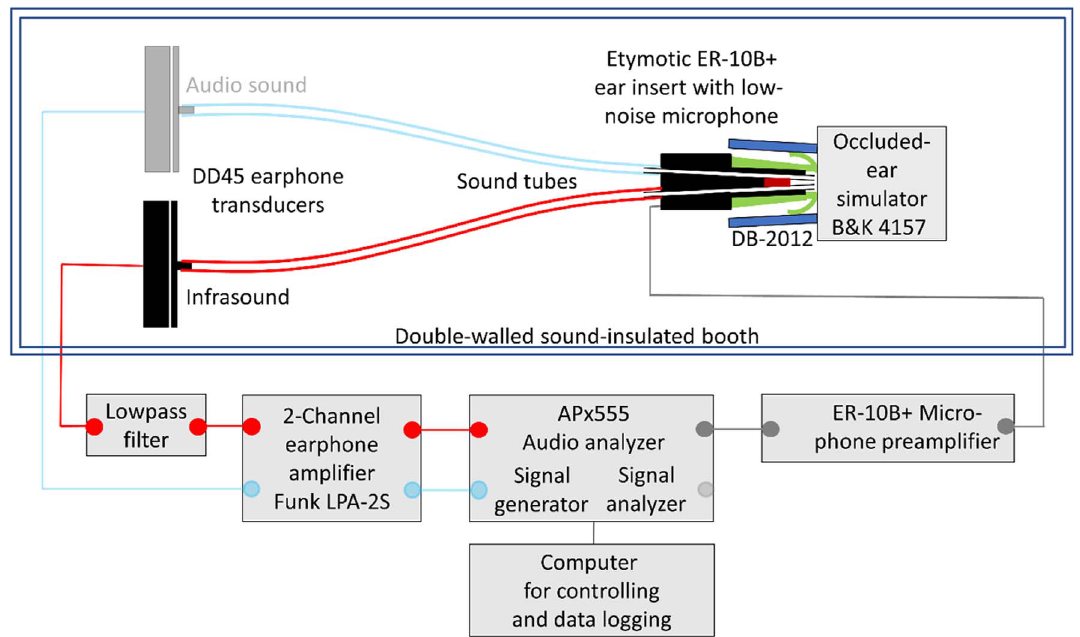
Figure 2. Block diagram of the setup for measuring technical distortions of the LDREPS. Red and gray connecting lines highlight the parts that were used in the present study. The second channel (light blue connecting lines) enables the LDREPS to present an additional audio-sound stimulus (not used in this study).